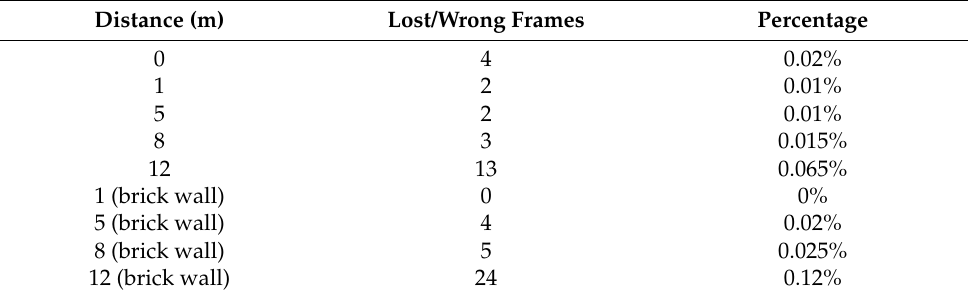
Table 3. Lost/wrong frames at different distances even with a brick wall in between.